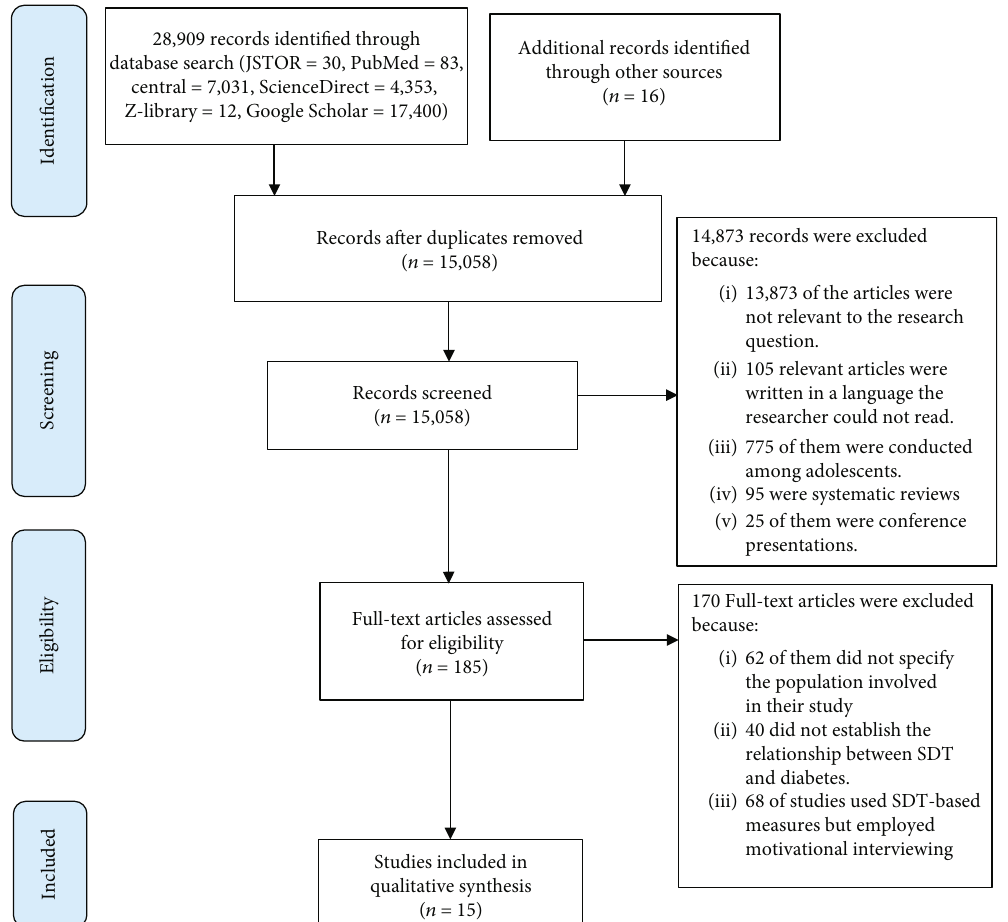
Figure 1: PRISMA fl ow diagram of records and screening